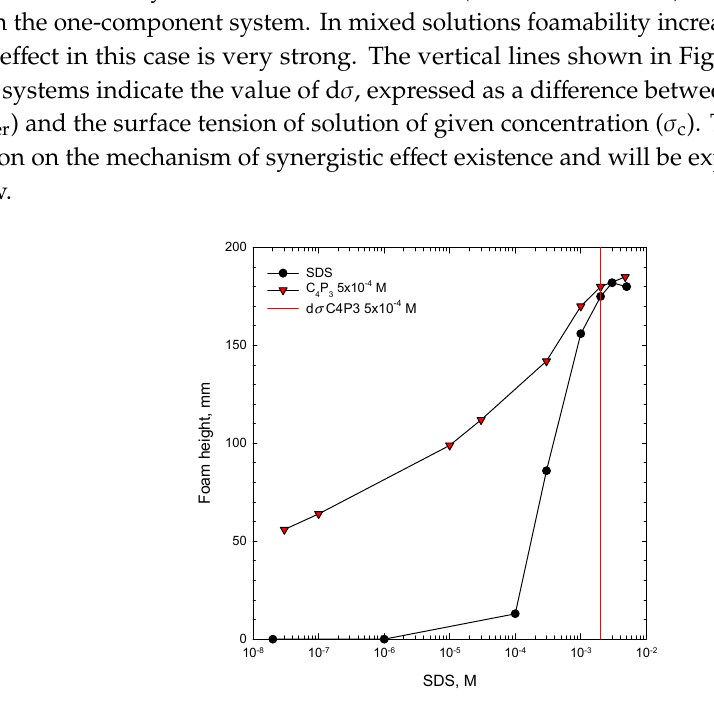
Figure 3. Foam height as a function of concentration of SDS one-component solution and its mixture with C 4 P 3 as the non-ionic additive. The determined value of the d σ critical synergistic concentration (CSC) is marked with a vertical line.